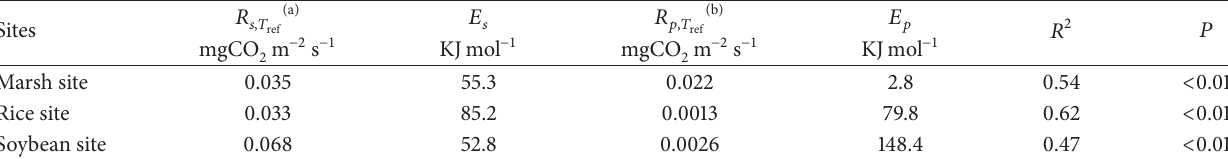
Table 3: The parameters in temperature response function for nighttime